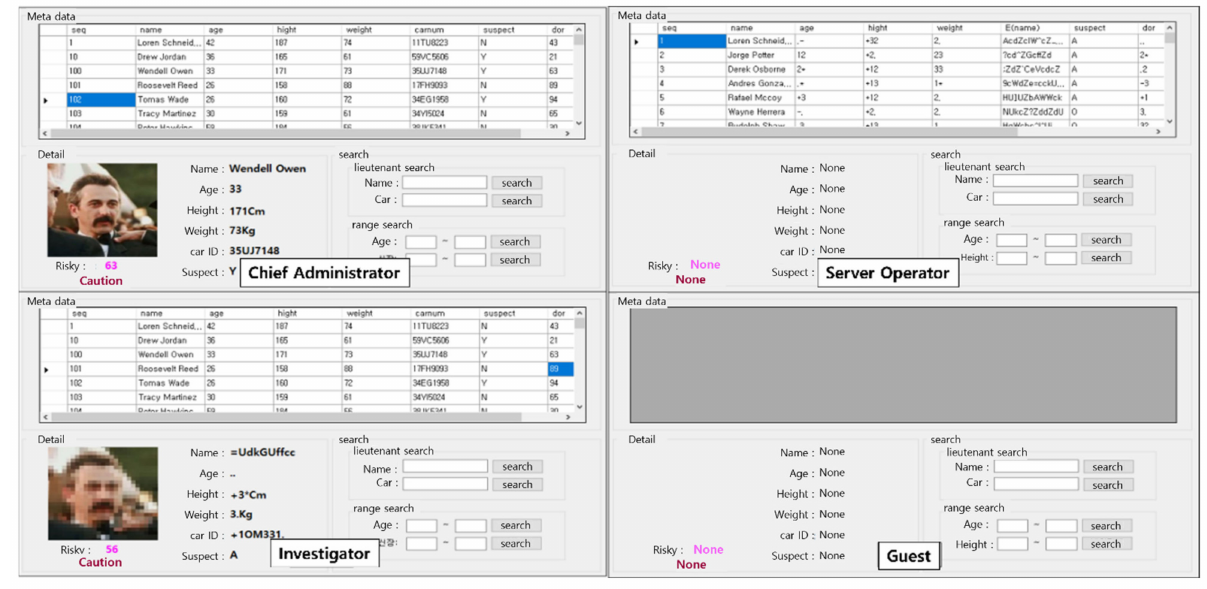
Figure 6. Scope of information disclosure by role.